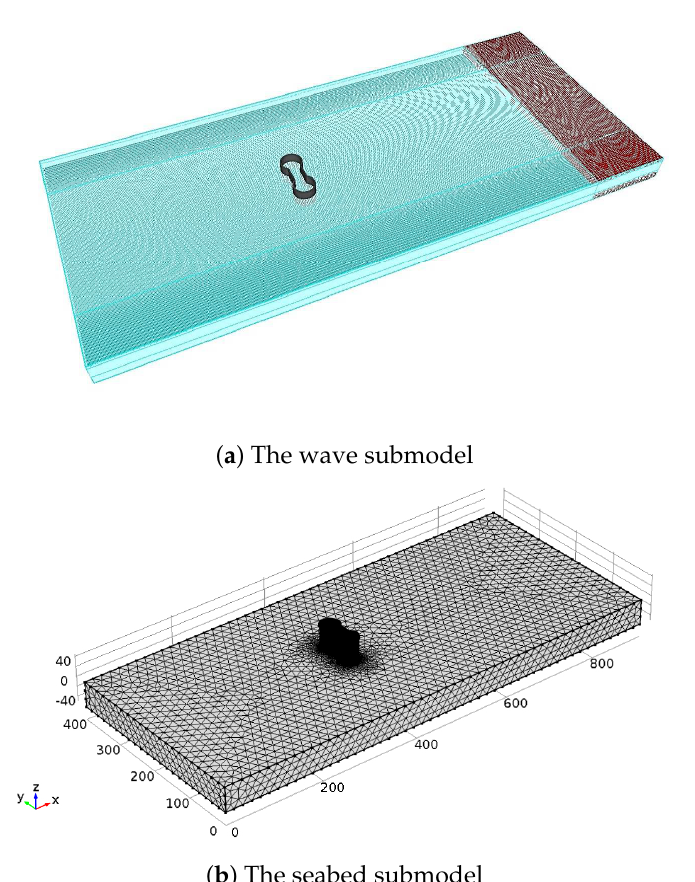
Figure 3. The mesh illustrations of the numerical